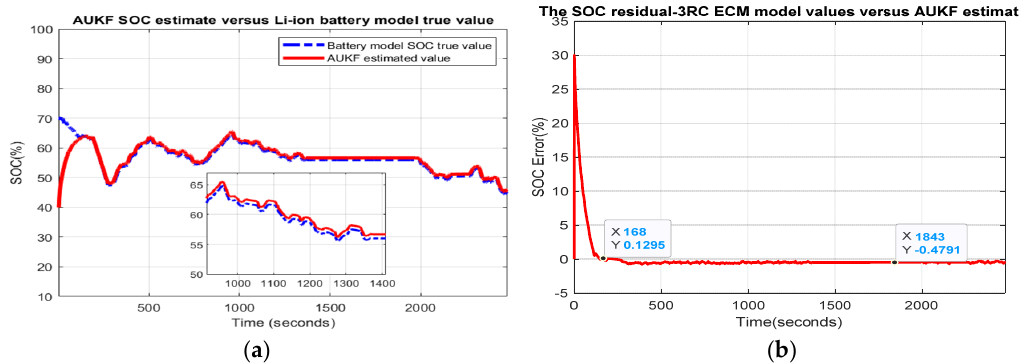
Figure A19. Robustness to changes in SOC initial value—SOCini = 0.4. ( a )AUKF SOC estimate versus battery SOC true value; ( b ) SOC residual.